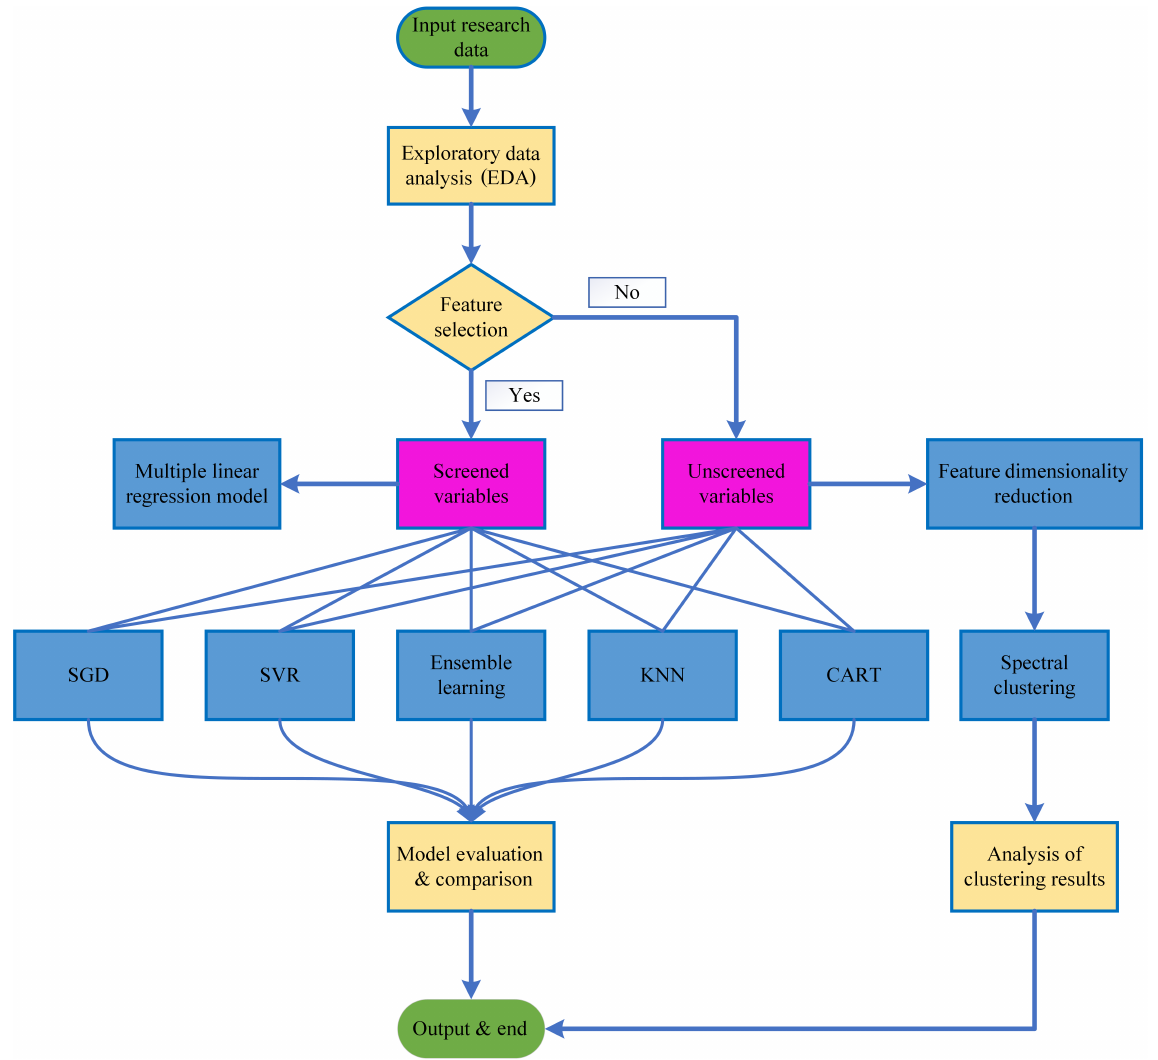
Fig. 7 Research methodology and process framework